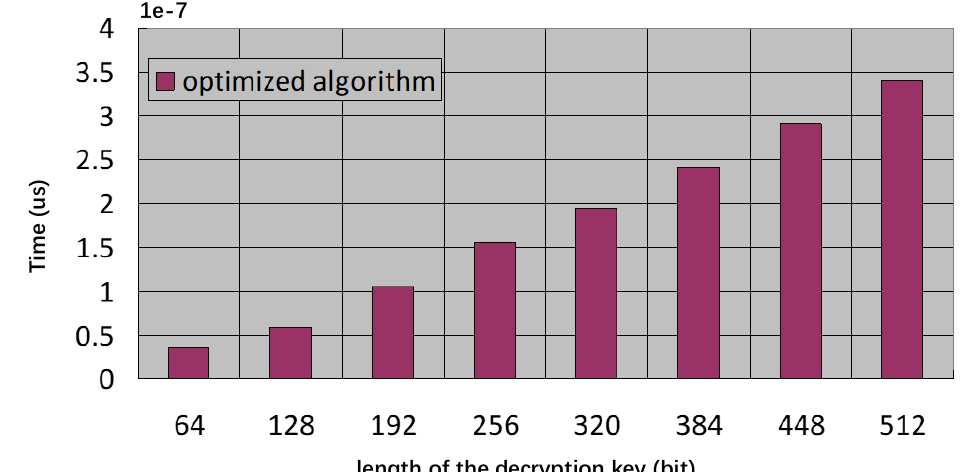
Figure 4. Decryption Time